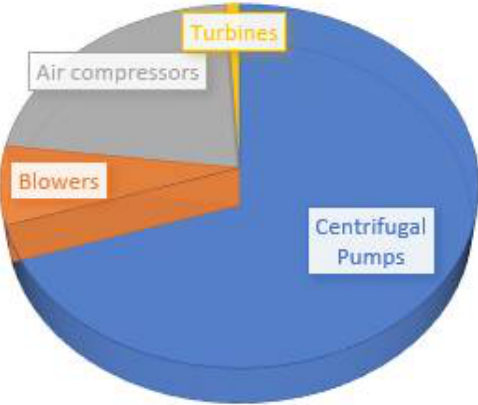
Figure 1. The distribution of maintenance costs in the chemical industry.